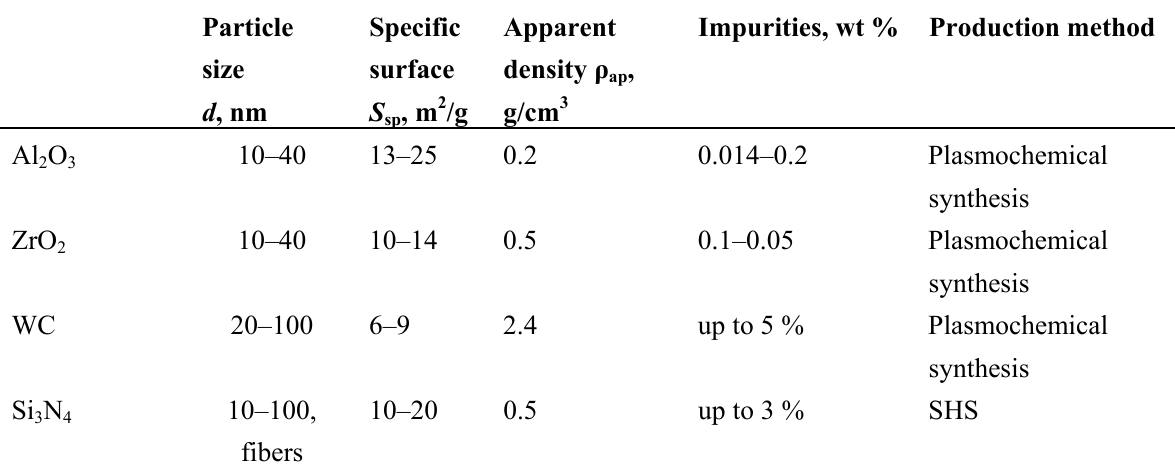
Table 5. Properties of added